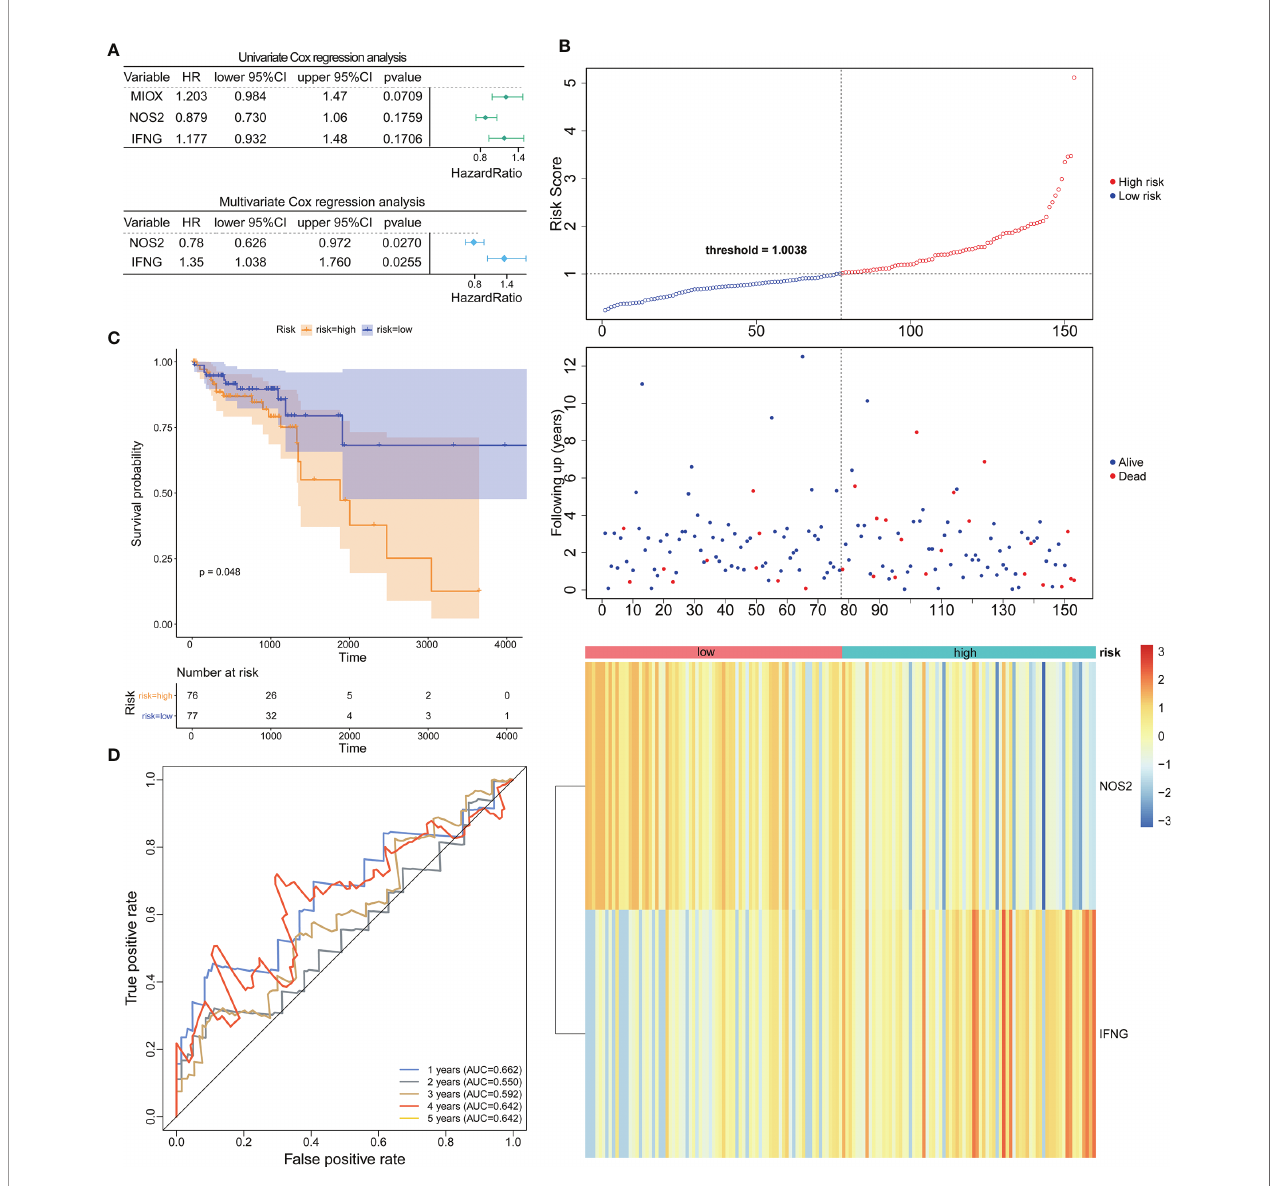
FIGURE 2 | Construction and evaluation of NOS2 and IFNG-based prognostic signature in the LCRC-training set. (A) Results of the univariate (top) and multivariate (bottom) Cox regression analysis regarding OS in the LCRC-training cohort. (B) The risk curve based on the risk score of each sample (top). The scatterplot based on the survival status of each sample (middle). The green and red dots represent survival and death, respectively. The heatmap displayed the expression levels of DE-FRGs in the high ‐ risk and low ‐ risk groups (bottom). (C) Kaplan ‐ Meier survival analysis of the high ‐ risk and low ‐ risk groups based on the risk model and median risk score. (D) AUC of time-dependent ROC curves veri fi ed the prognostic performance of the risk score in the LCRC-training